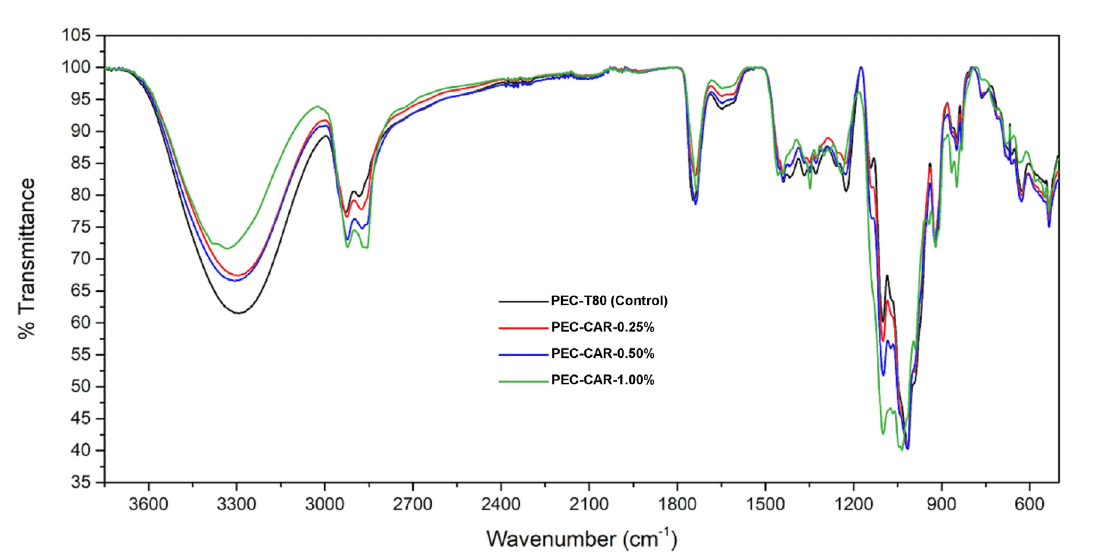
Figure 4. Infrared spectrum of PEC membranes with and without CAR (control).